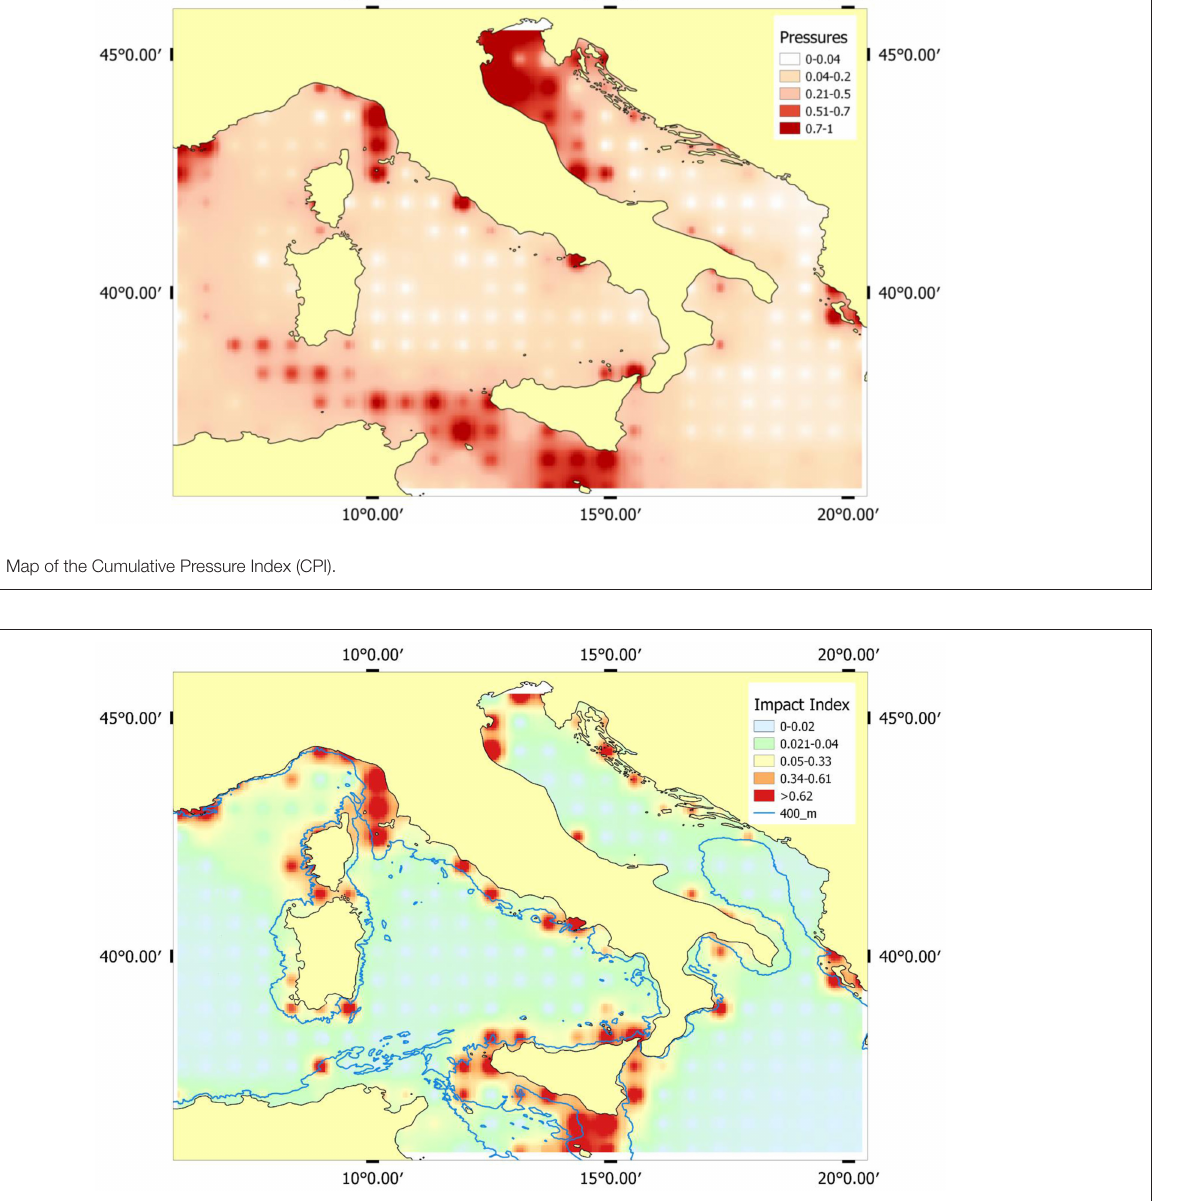
FIGURE 13 | Map showing the Impact Index, ranked into 4 classes of impact ( ≤ 0.04 low impact; 0.05–0.33 moderate impact; 0.34–0.61 high impact; > 0.62 very high impact) based on the distribution of the